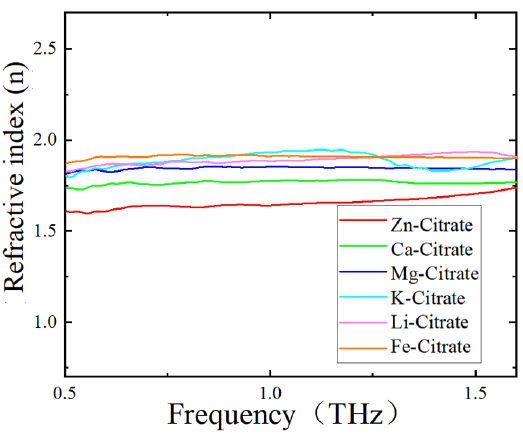
Figure 7. Refractive indices of CSs measured by THz – TDS system. Table 5. Refractive index data of CSs.